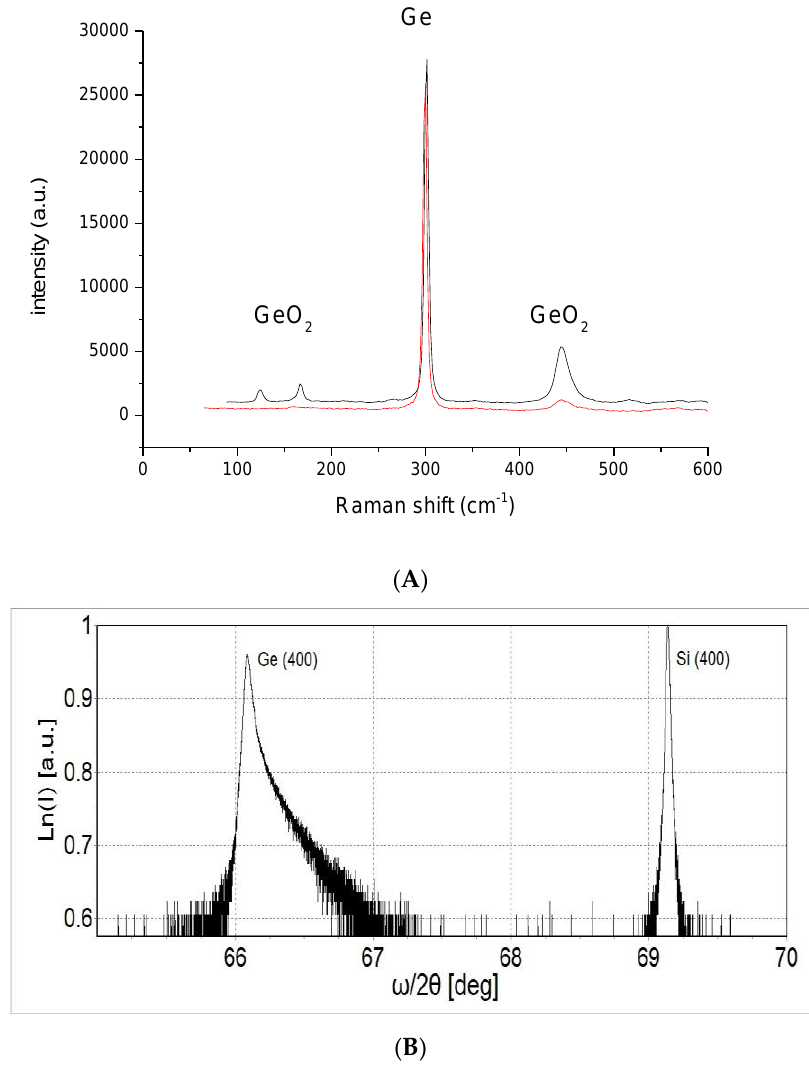
Figure 5. Identification of germanium oxide by ( A ) Raman spectroscopy and ( B ) XRD. Germanium oxide and germanium peaks observed on the blister on the surface of Gr/Ge(001)/Si(001). The bottom (red) and upper (black) lines correspond to the samples after 3 and 150 h of water vapor treatment, respectively.